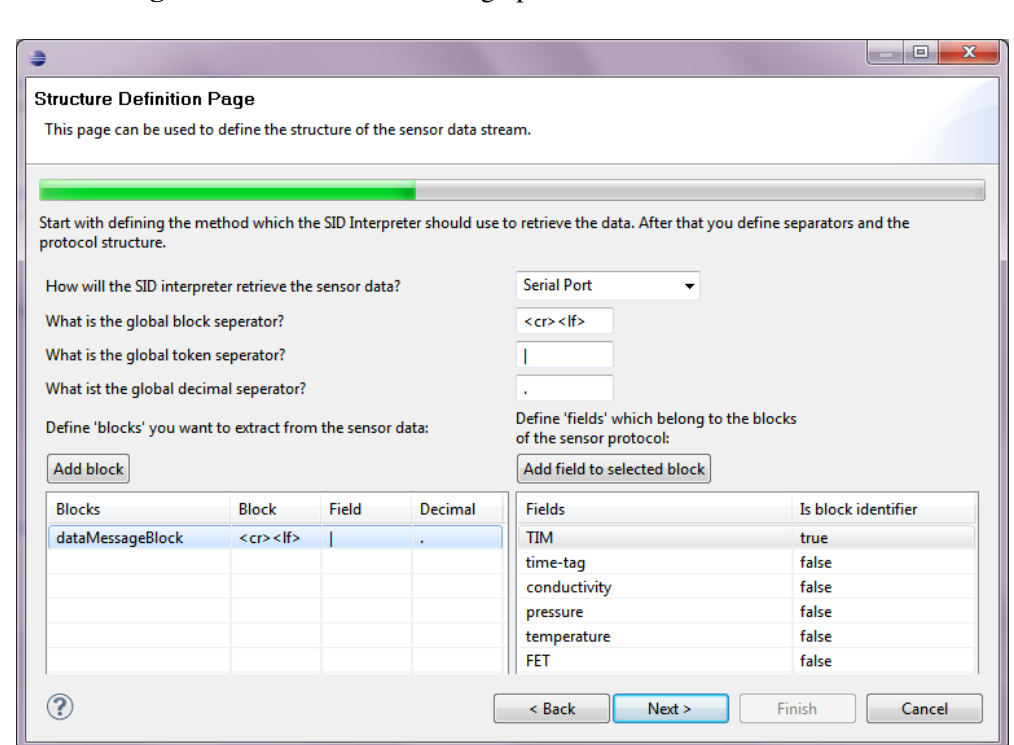
Figure 10. Sensor data message protocol defined in SID